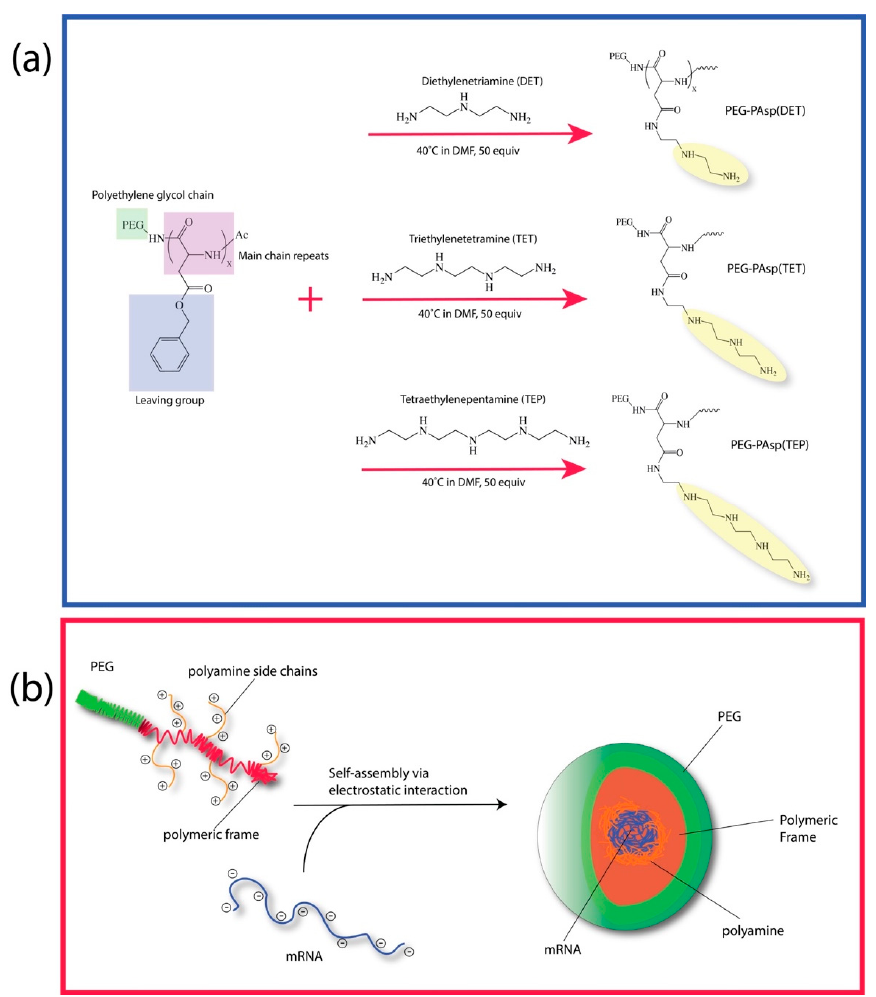
Figure 1. ( a ) Graphical illustration on the assembly of the polyamine of various length (DET, TET, and TEP) respective via the aminolysis of the benzylic alcohol side chains and ( b ) the subsequent condensation with mRNA into nanomicelles in physiological environment.